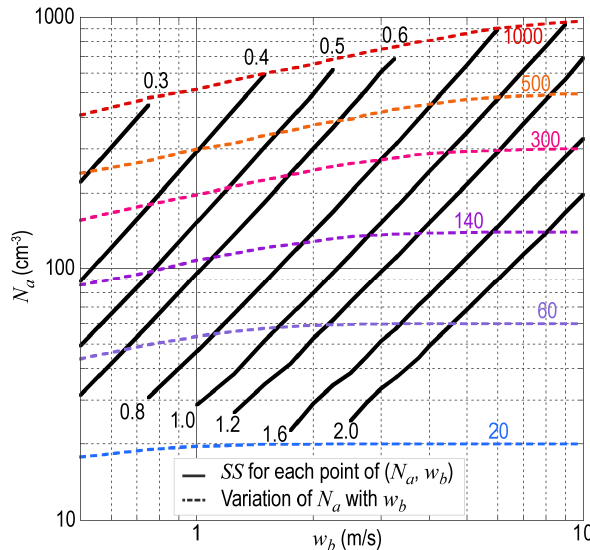
Fig. 7. The CCN spectra can be calculated using measurements or model simulations of N a and S(w b ). This chart was drawn using data from P¨oschl et al. (2010) for the activation of organic aerosol particles with κ =0.13 as observed for pristine tropical rainforest air. κ =0.3 is more representative for most other continental aerosol regimes. Increasing κ would lower the S values in the figure (Reut- ter et al.,